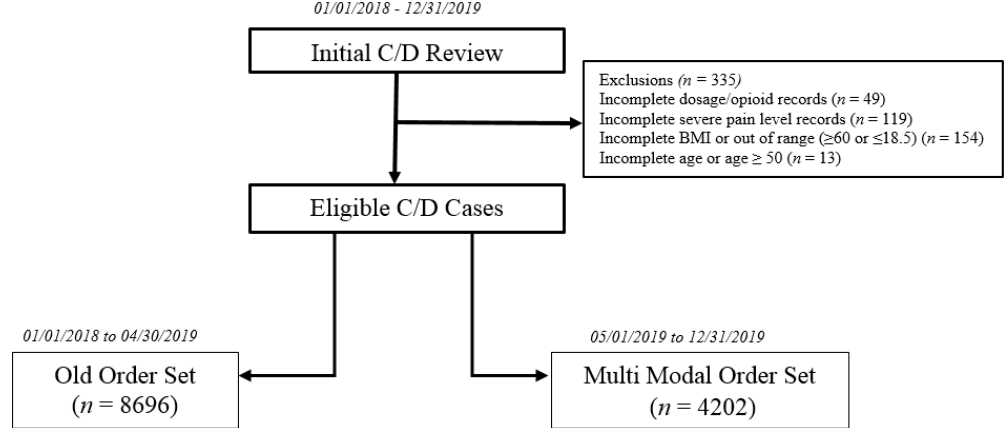
Figure 1. Cesarean Delivery (C/D) Patients Exclusion and Assignment Criteria.